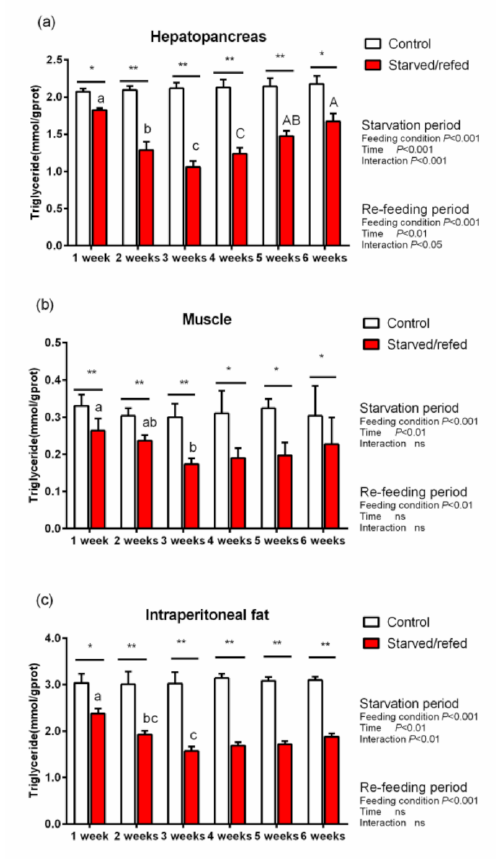
Figure 4. The triglyceride (TG) contents in the hepatopancreas ( a ), muscle ( b ) and intraperitoneal fat ( c ) of O. macrolepis exposed to starvation and refeeding periods. Different superscript letters in the same column indicate a significant difference between successive times ( p < 0.05). Significant differences between the two groups at each sampling time are identified with different markers (* p < 0.05; ** p < 0.01; ns, no significant